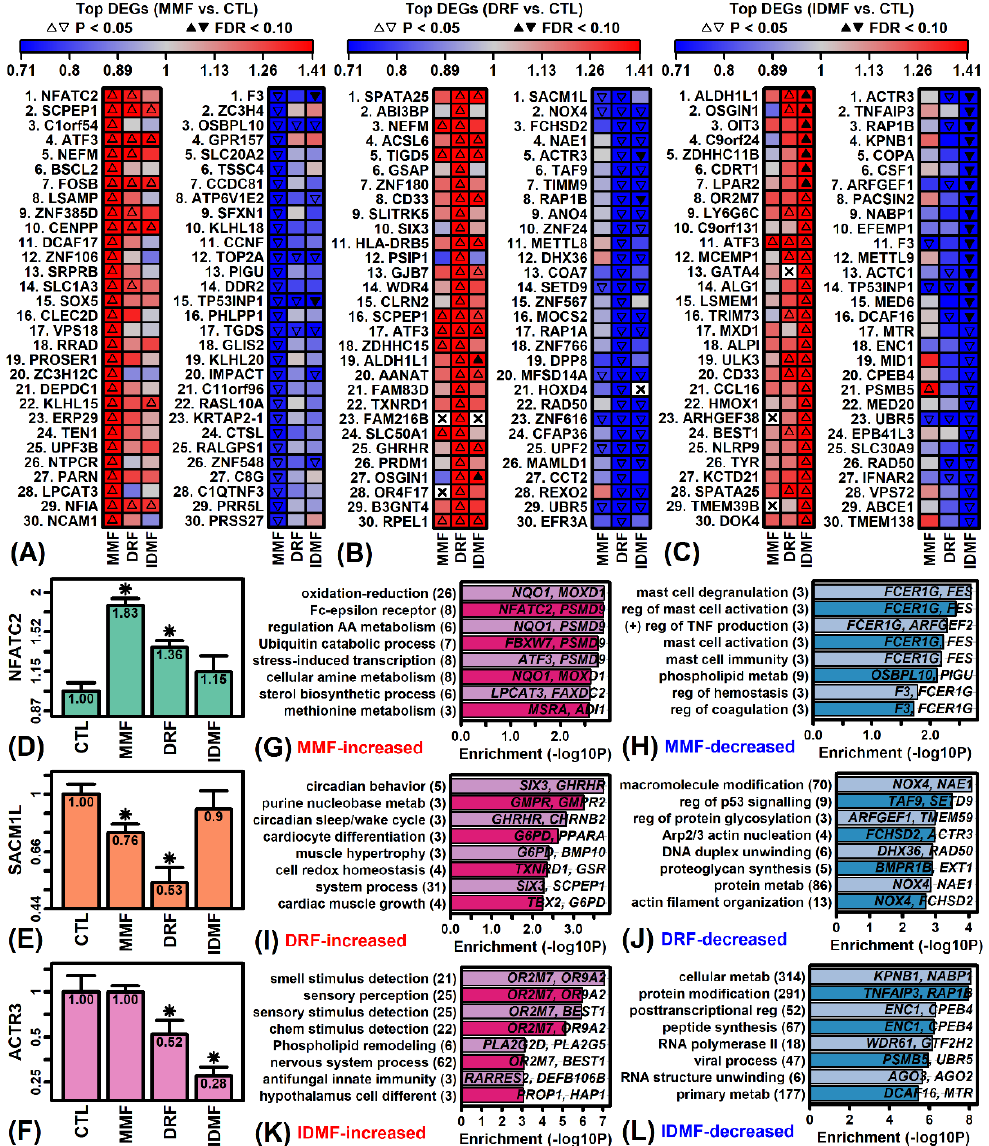
Figure 2. Top-ranked DEGs. ( A – C ) Top 30 DEGs most strongly altered by ( A ) MMF, ( B ) DRF, and ( C ) IDMF. The top-ranked 30 increased and decreased genes are shown for each compound (i.e., lowest p -values with FC > 1.25 or FC < 0.80). ( D ) NFATC2 . ( E ) SACM1L . ( F ) ACTR3 . In ( D – F ), average expression (log 2 scale) is shown for each treatment (±1 standard error; * p < 0.05, comparison to CTL treatment). Expression is normalized to the average value in the CTL treatment for each gene. ( G – L ) GO BP terms enriched among ( G , I , K ) increased and ( H , J , L ) decreased DEGs. The number of DEGs associated with each GO term is given in parentheses (left margin) and example DEGs are listed within each figure.